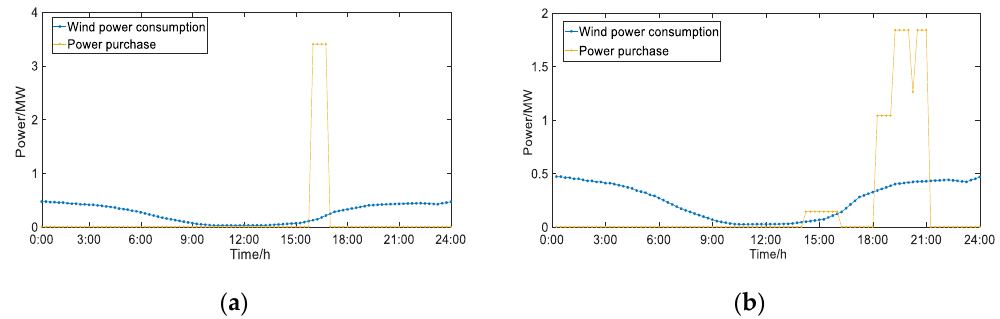
Figure 19. Wind power consumption and power purchase. ( a ) T c = 4 h. ( b ) T c = 1 h.